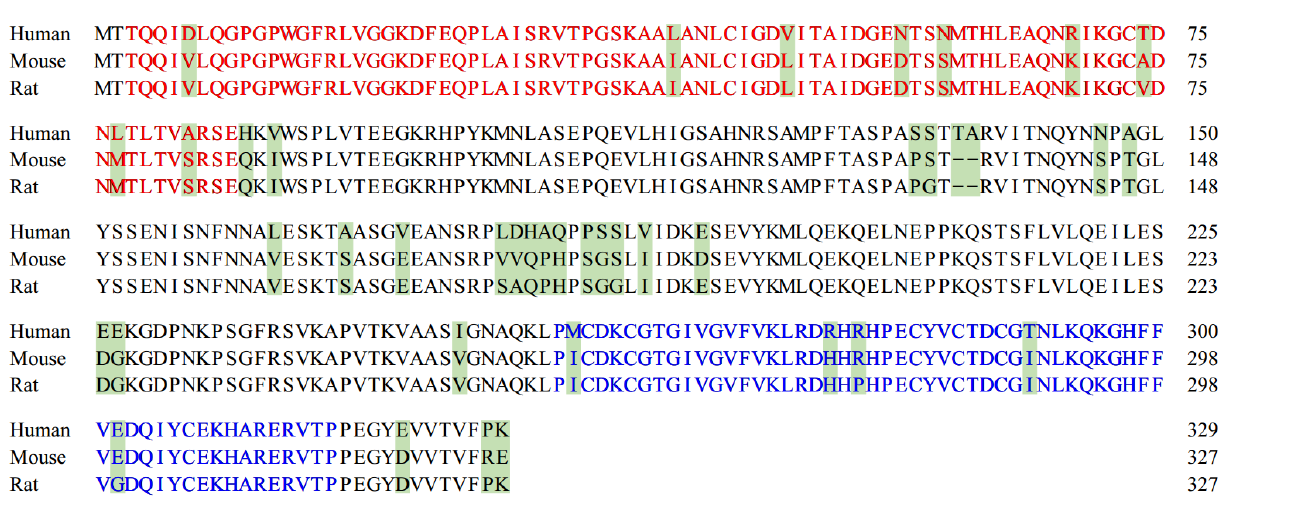
FIGURE 1: Comparison of the amino acid sequences of PDLIM1 between human, mouse and rat. The different amino acids are shaded. The red ones represent the PDZ domain, and the blue ones represent the LIM domain. UniProt Entry of PDLIM1: No. O00151 (Human), No. O70400 (Mouse) and No. P52944